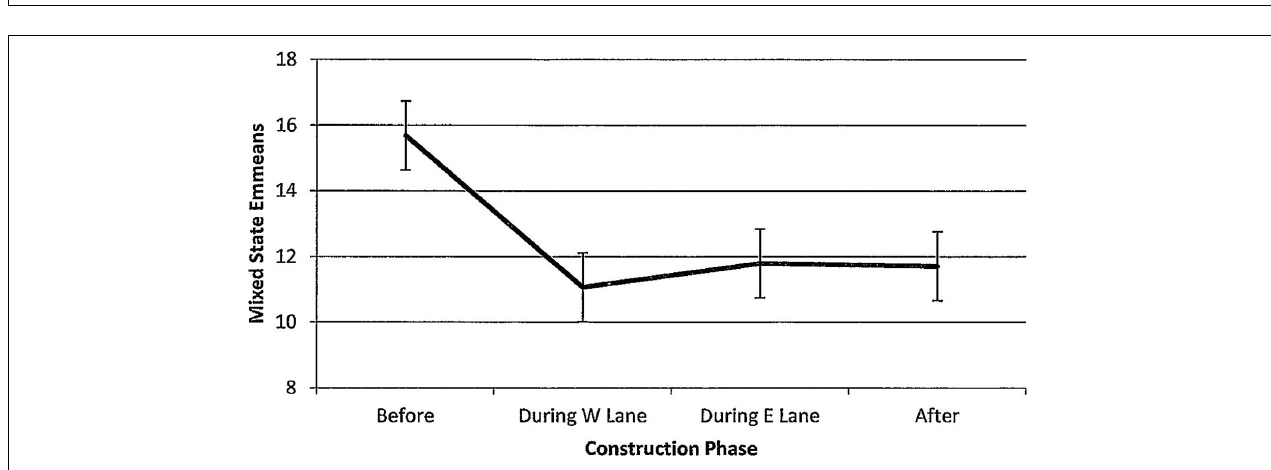
FIGURE 11 | Estimated marginal means of numbers of dolphins forage-feeding in the construction zone before, during, and after construction.